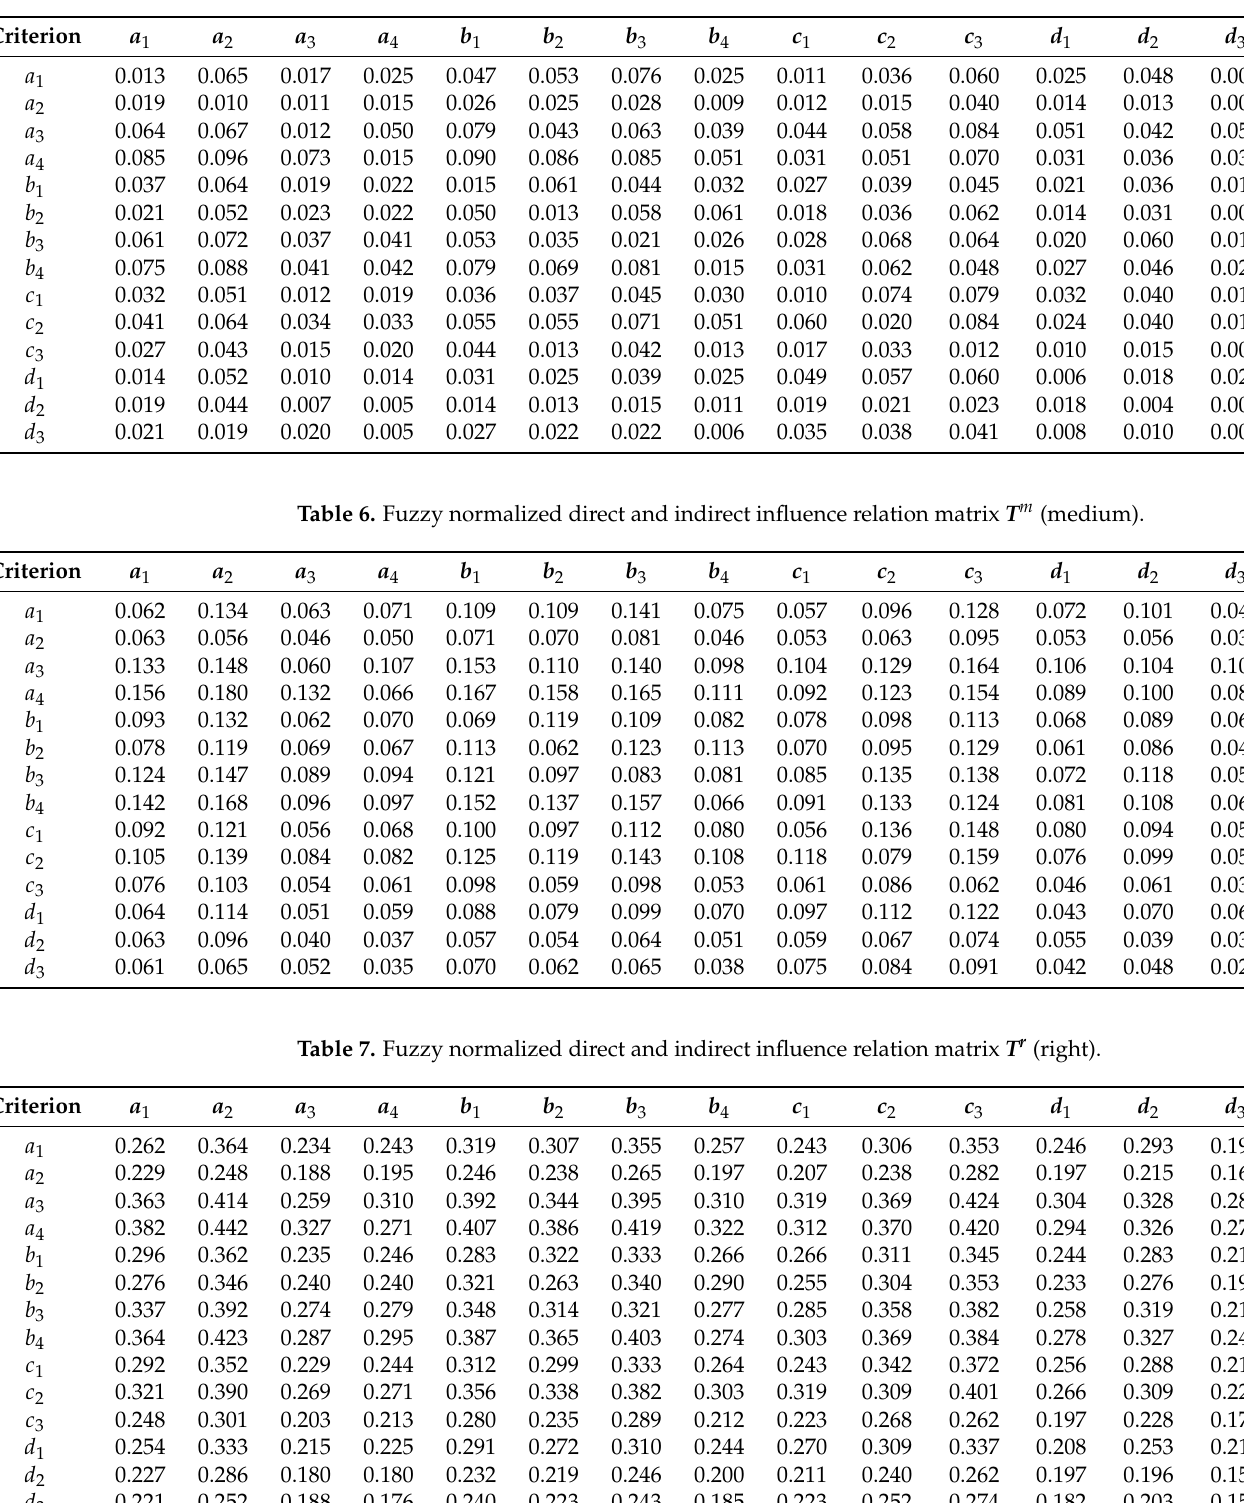
Table 5. Fuzzy normalized direct and indirect influence relation matrix T l (left).